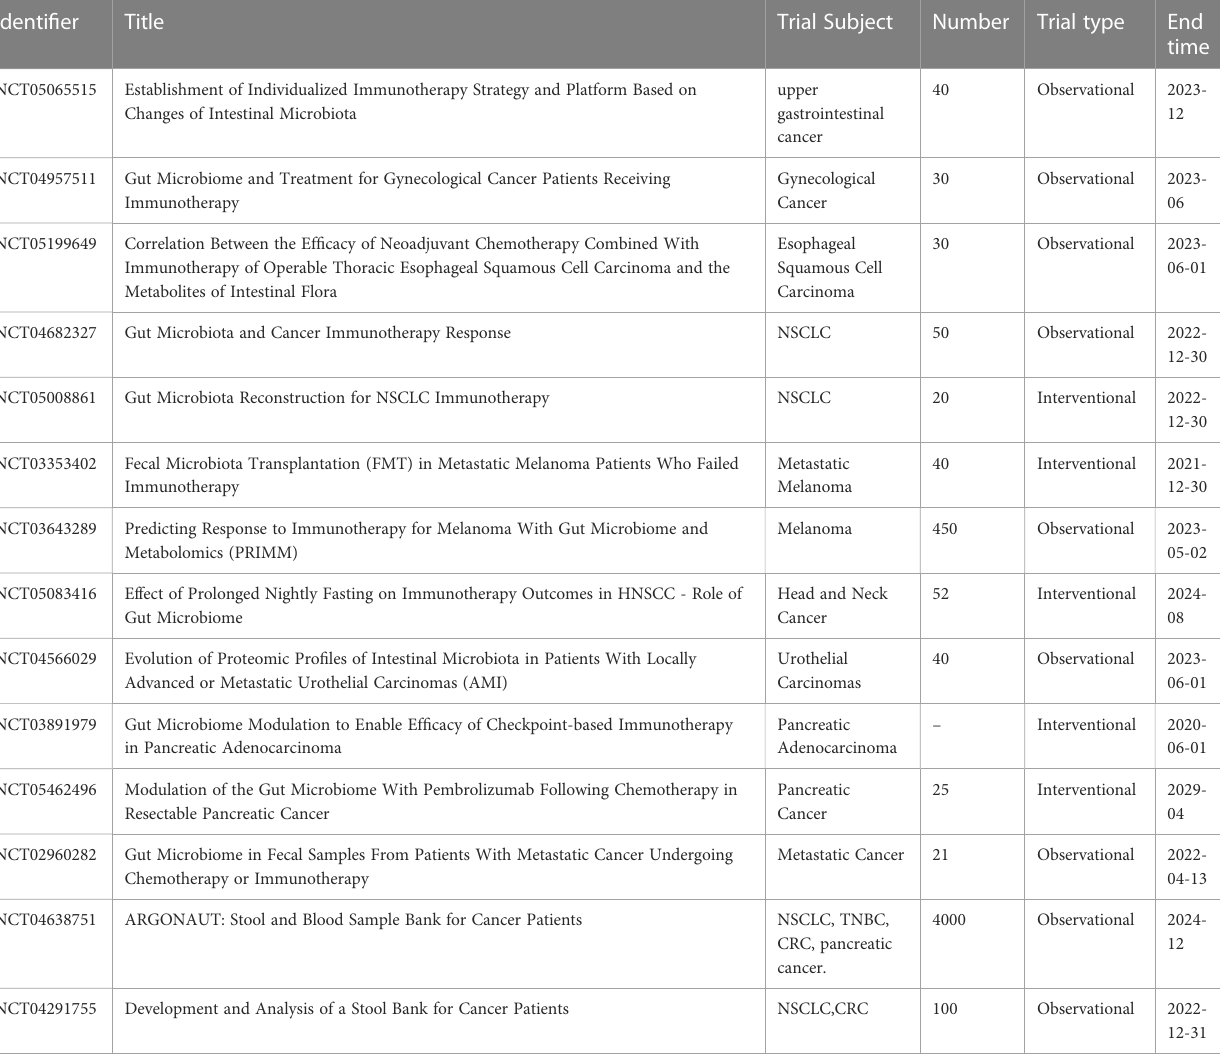
TABLE 2 Clinical trial of the in fl uence of intestinal microorganisms on cancer